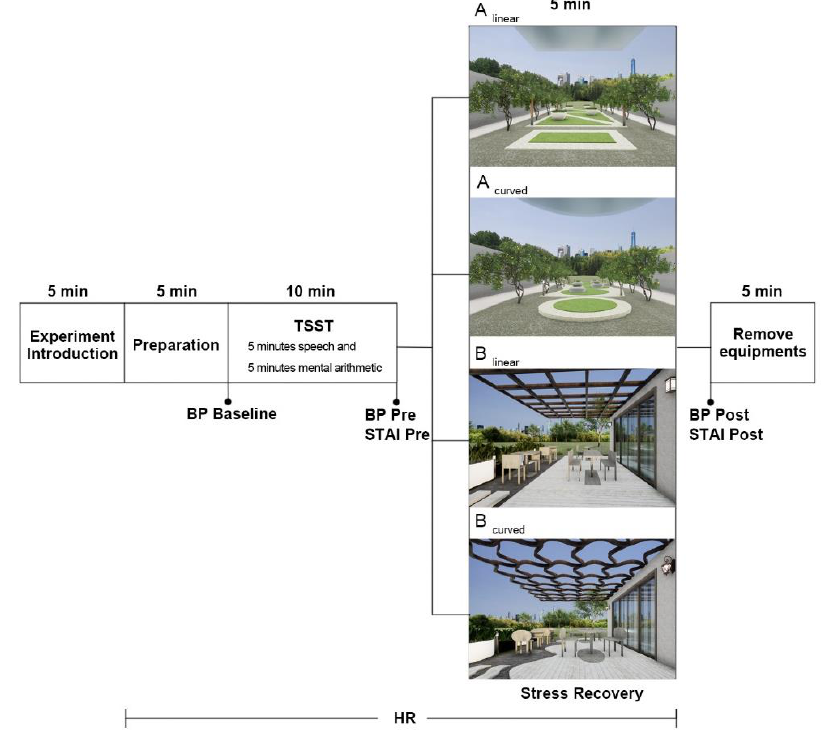
Figure 4. Experiment